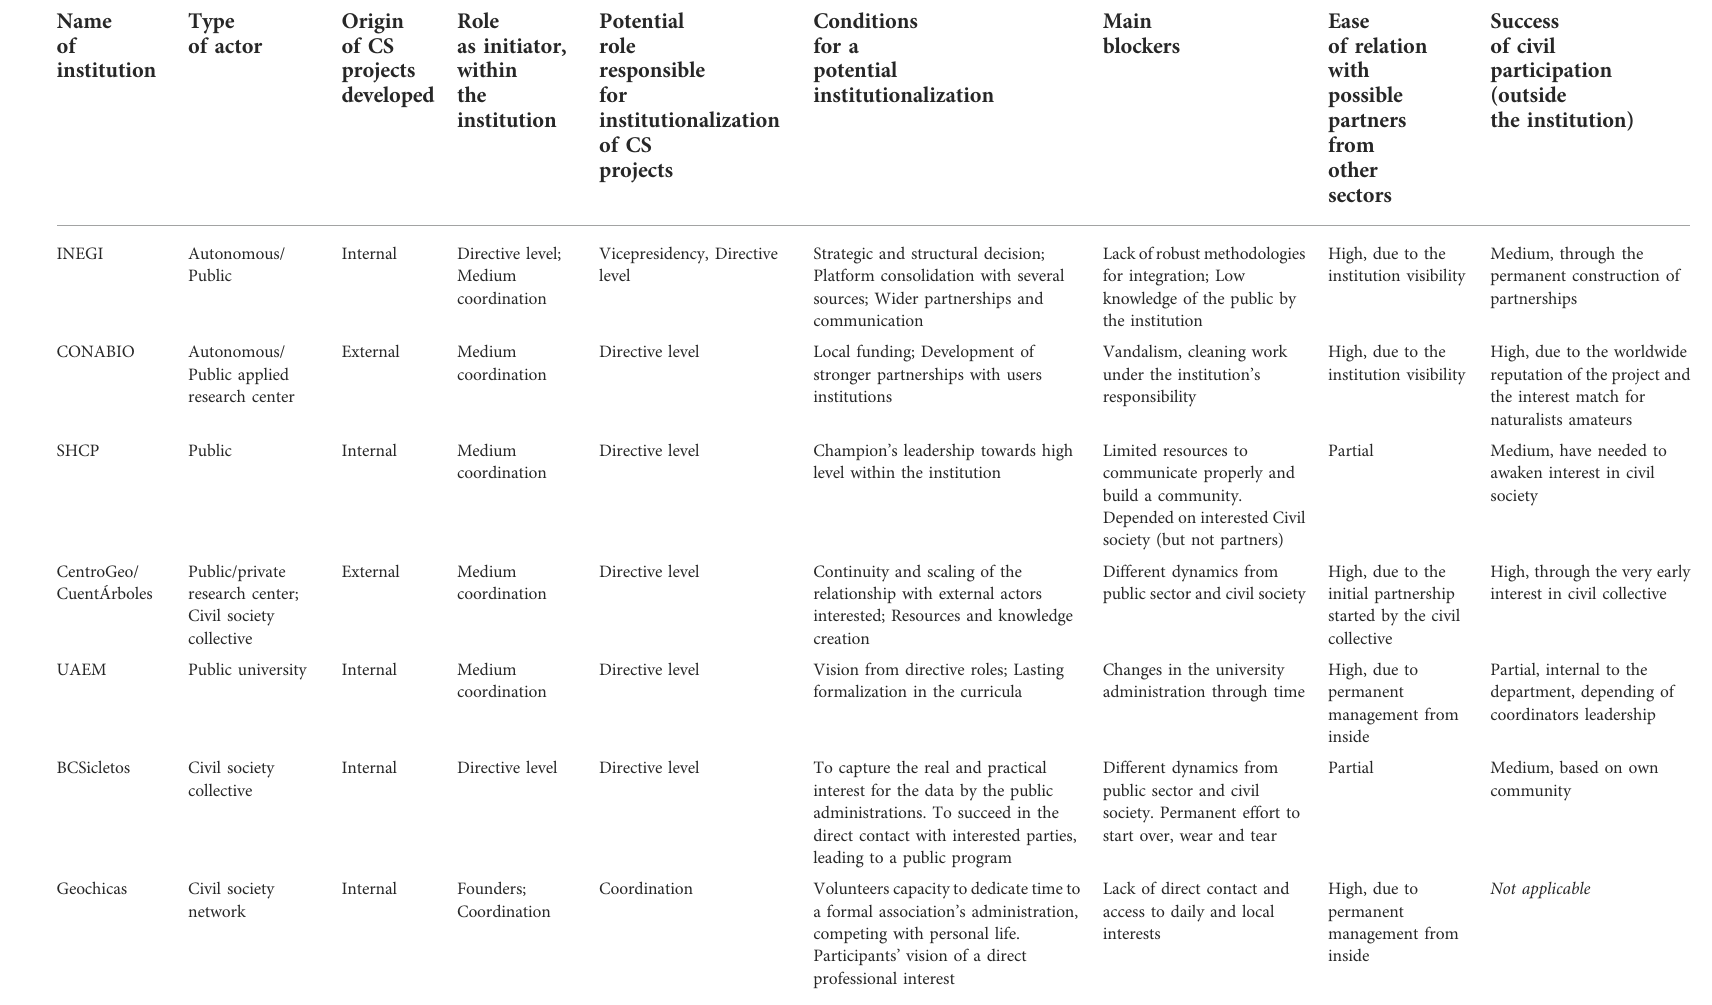
TABLE 1 Synthesis of the dynamics of emergence and insertion of citizen science in public institutions, based on the present research. Source: